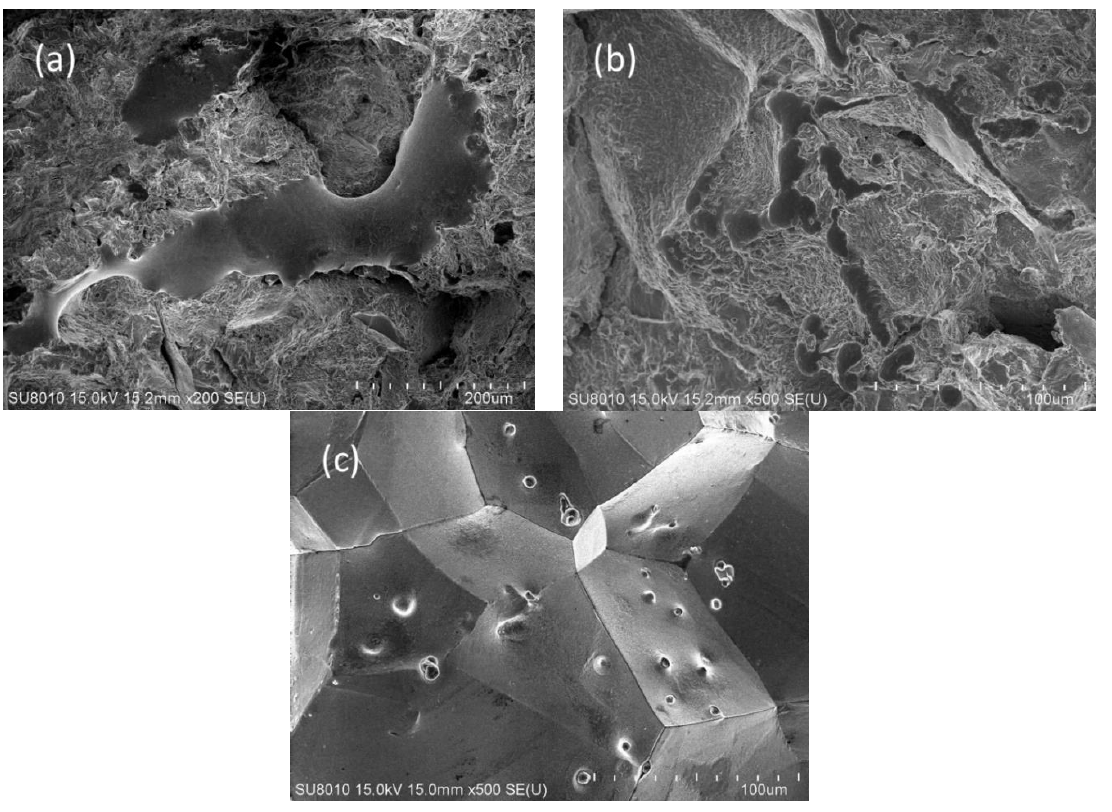
Figure 2. Fracture surfaces of A-286 tested at ( a ) 1180 °C; ( b ) 1200 °C; ( c ) 1220